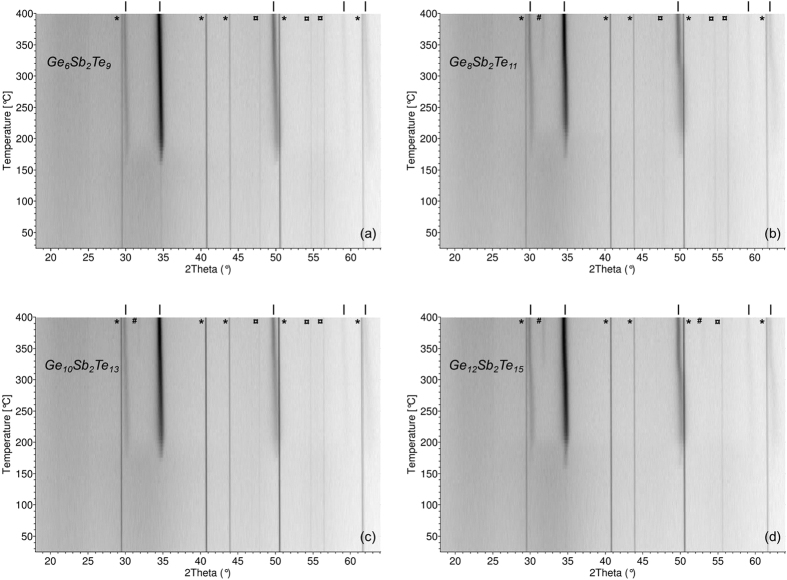
Temperature dependent XRD patterns of Ge6Sb2Te9 (a), Ge8Sb2Te11 (b), Ge10Sb2Te13 (c), and Ge12Sb2Te15 (d) PLD thin films. *Symbols are due to XRD signal coming from Al2O3 high-temperature sample cell. ¤Symbols describe signal of the substrate (Si). |Symbols show diffraction angles of crystallized GST thin films. #Denote diffraction angles of possible traces of cubic Ge.